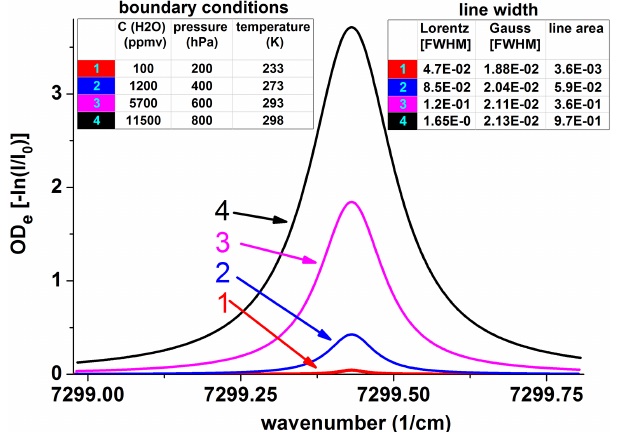
Figure 5. Collisional line widths γ Lorentz induced by foreign broad- ening (of the used 1370nm transition) as a function of flight height (scaled as total pressure) for three atmospheric temperatures ( − 50 ◦ C, − 25 ◦ C, + 25 ◦ C), indicating the strong pressure and tem- perature dependence of the collisional width. In addition the influ- ence of self-broadening on the line width is shown for high, medium and low H 2 O concentrations (dashed lines). A clear hierarchy be- comes visible with the largest impact from pressure, then tempera- ture, then matrix composition. Thus the line width can be used for optical pressure determination if the latter two can be compensated for, i.e. if concentration (self-broadening) and temperature effects are corrected